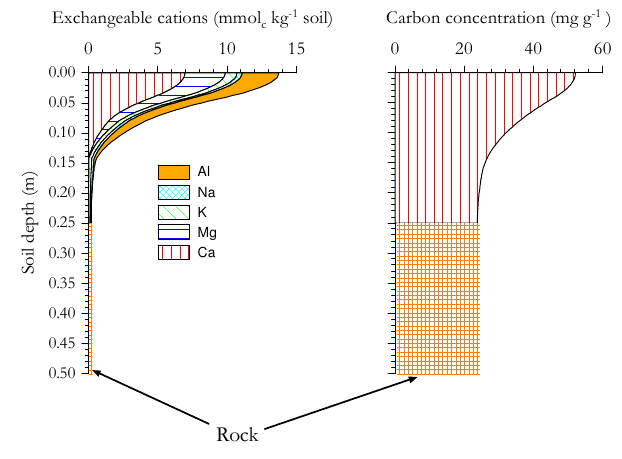
Fig. 5. Forest vegetation above a Leptosol in Venezuela (ELD-34). Fig. 6 Fig. 6. Profiles of exchangeable cations and soil carbon for a Hy- perskeletic Leptosol (Orthodystric) in Venezuela